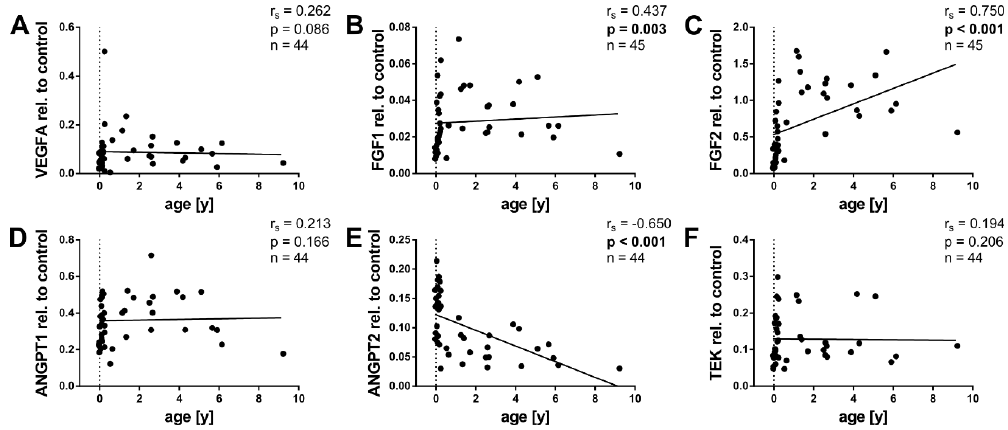
Figure 2. Association of angiogenic gene expression in pediatric WAT with age. Total RNA was isolated, reverse transcribed, and subjected to qPCR analysis using specific primer pairs as indicated. Respective gene expression was calculated as described in Methods and plotted against age. ( A ) VEGFA expression showed no significant correlation with age. ( B , C ) FGF1 and FGF2 expression, however, correlated positively with age. ( D – F ) While ANGPT1 and the receptor TEK showed no significant correlation with age ( D , F ), ANGPT2 displayed a negative correlation ( E ). Spearman correlation coefficient r s and p value, as well as number of subjects, are given in each scatter plot. Significant p values ( p < 0.05) are indicated in bold. Trend lines were calculated as linear regressions.